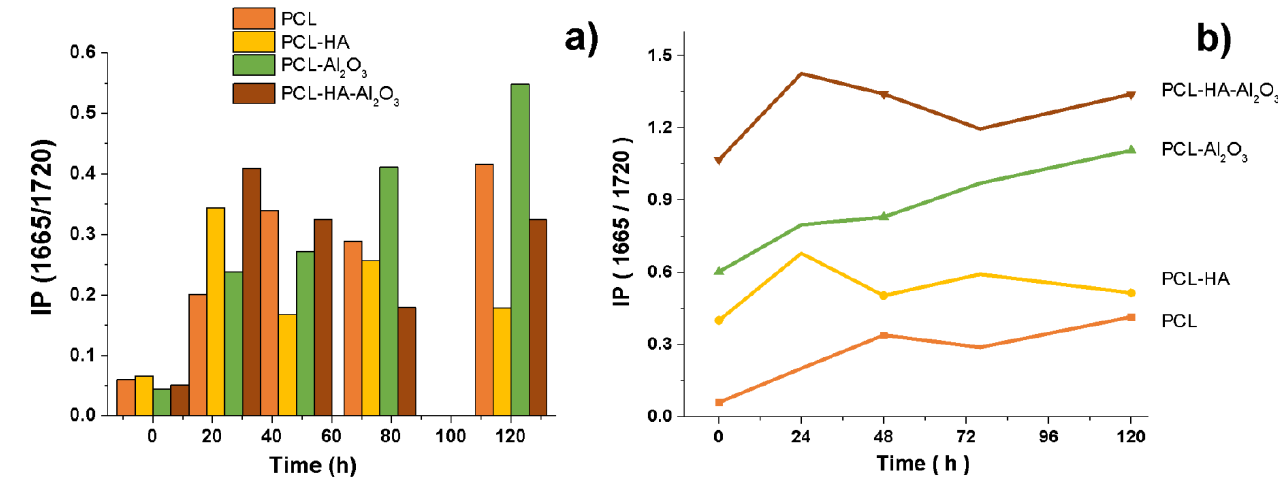
Figure 10. IP(1660/1720) for the IR spectra of cellular proliferation on PCL, PCL-HA, PCL- α -Al 2 O 3 , and PCL-HA- α -Al 2 O 3 (coulomb form ( a ) and stacked lines ( b )).